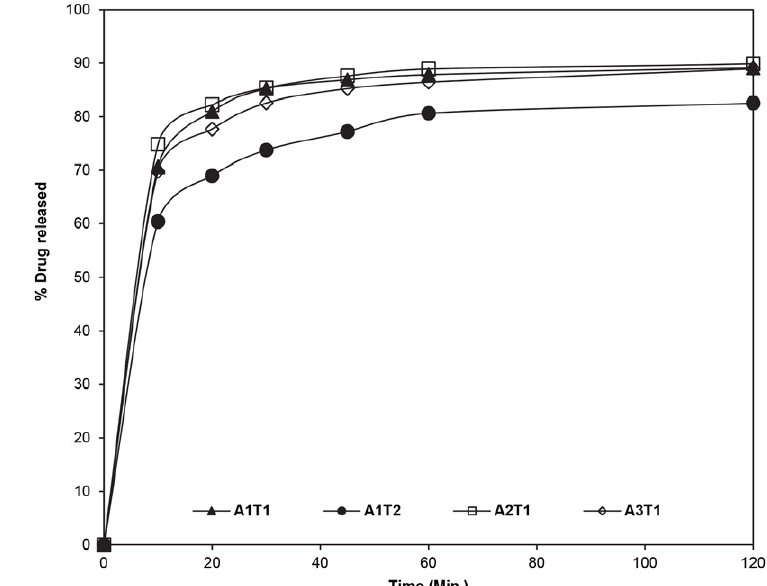
Figure 4. In vitro drug diffusion profile of the